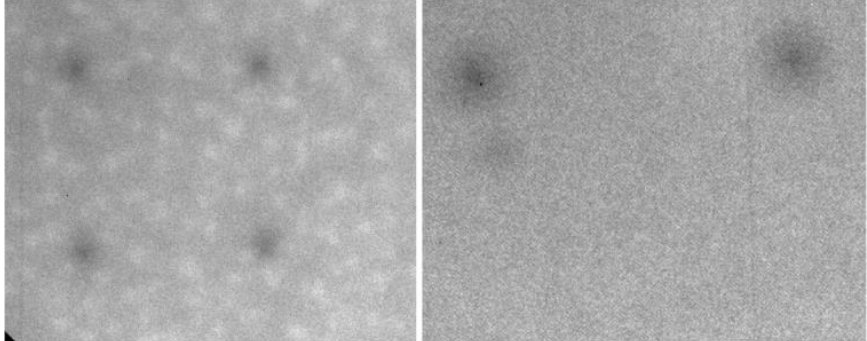
Figure 6. ICCD imaging, on ( left ) sinusoidal and on ( right ) pulse. The ICCD camera used is a Princeton Instrument PI MAX; each picture was integrated over 5 periods. Gate is 5 microseconds for a half-period in the positive half-wave. The spacers (dark dots) are separated by 3 cm.